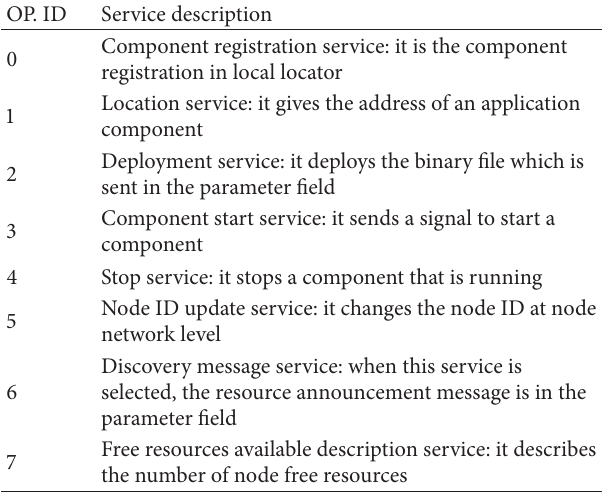
Table 1: Platform services and their corresponding op. ID. OP.